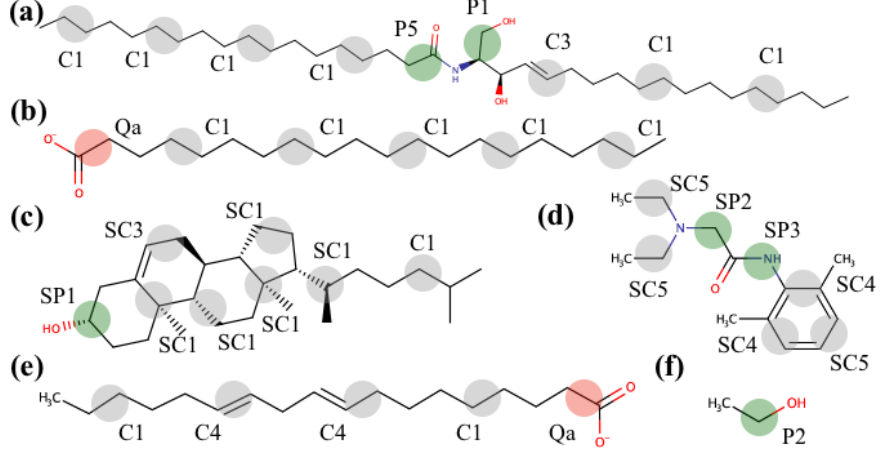
Figure 1. Structural formulae of the SC membrane components: DPCE ( a ), behenic acid ( b ), choles- terol ( c ); lidocaine ( d ); penetration enhancers: linoleic acid ( e ) and ethanol ( f ). Coarse-grained beads and their corresponding MARTINI force field types are also shown schematically.